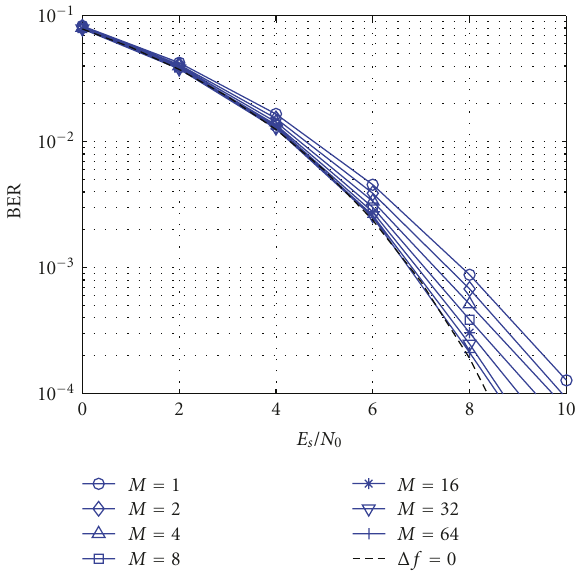
= 10% maximum relative CFO Figure 13: Performance for Δ f ( k ) CFO for di ff erent numbers M of subcarriers per block, assuming N = 1024 subcarriers and Q = 64 subcarriers per user.